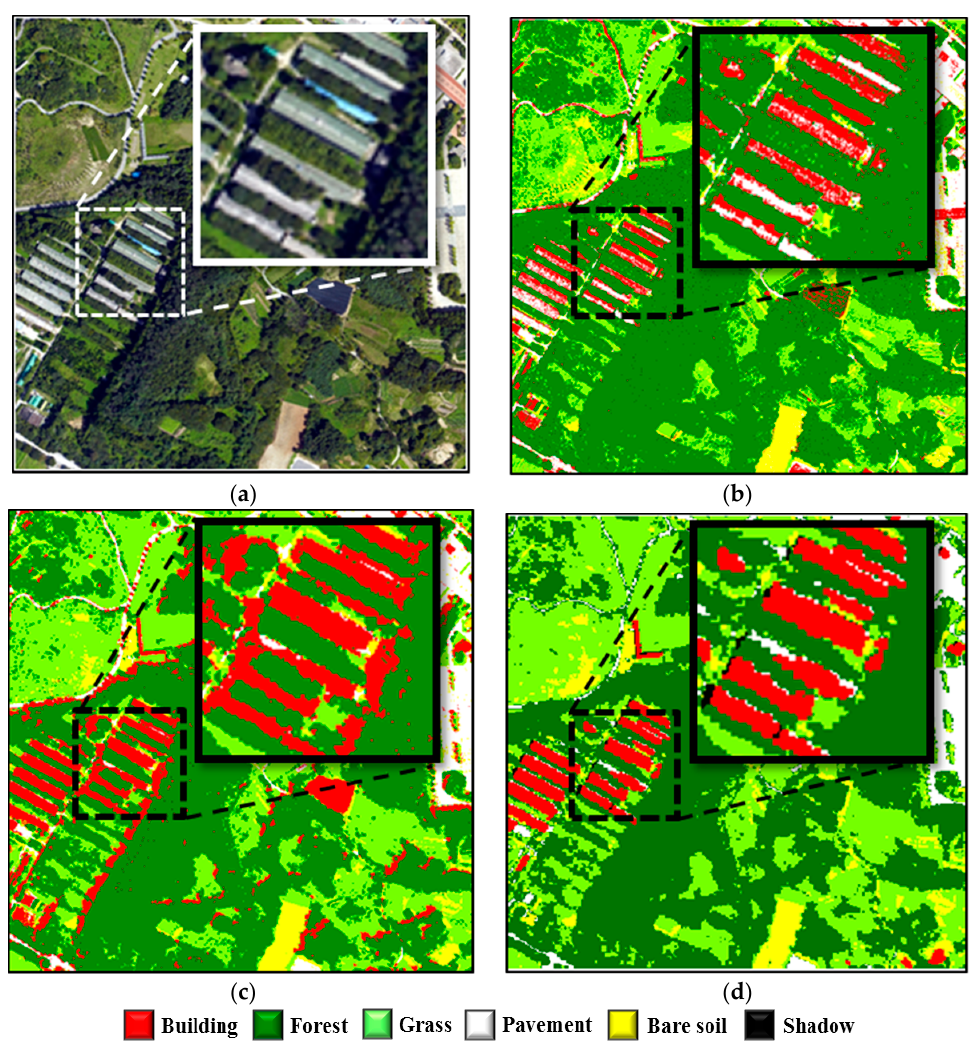
Figure 7. Results for site 2: ( a ) aerial image; ( b ) Max-Min method; ( c ) SSI, nDSM method; and ( d ) the new method.